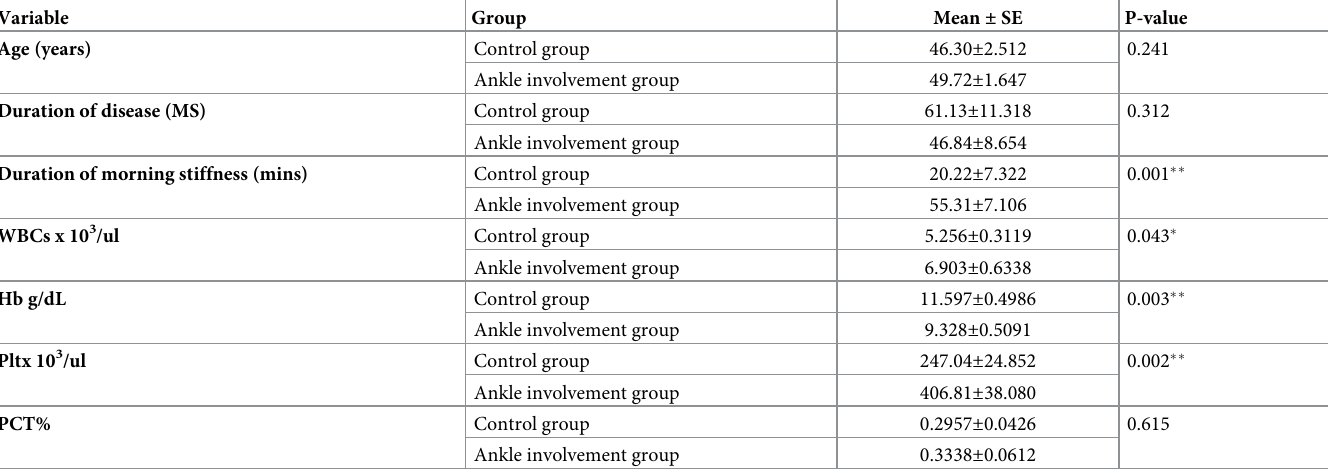
Table 2. Mean ± standard error of the mean (SE) of age, disease characteristics and hematological profiles among the two study groups: The control group (patients without ankle involvement, n = 23) and ankle involvement group (patients with ankle involvement, n = 32) along with the p-value of the independent samples t-test.